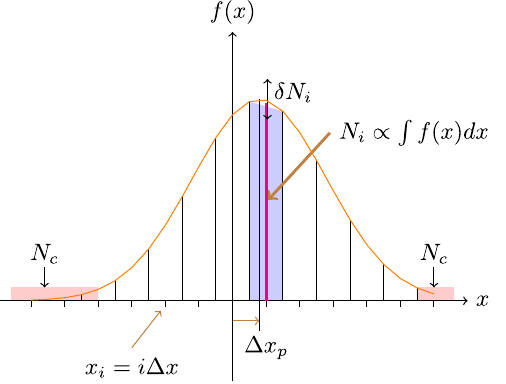
FIG. 23. Schematic of the IPM acquisition, errors and selec- tion of the measured data.